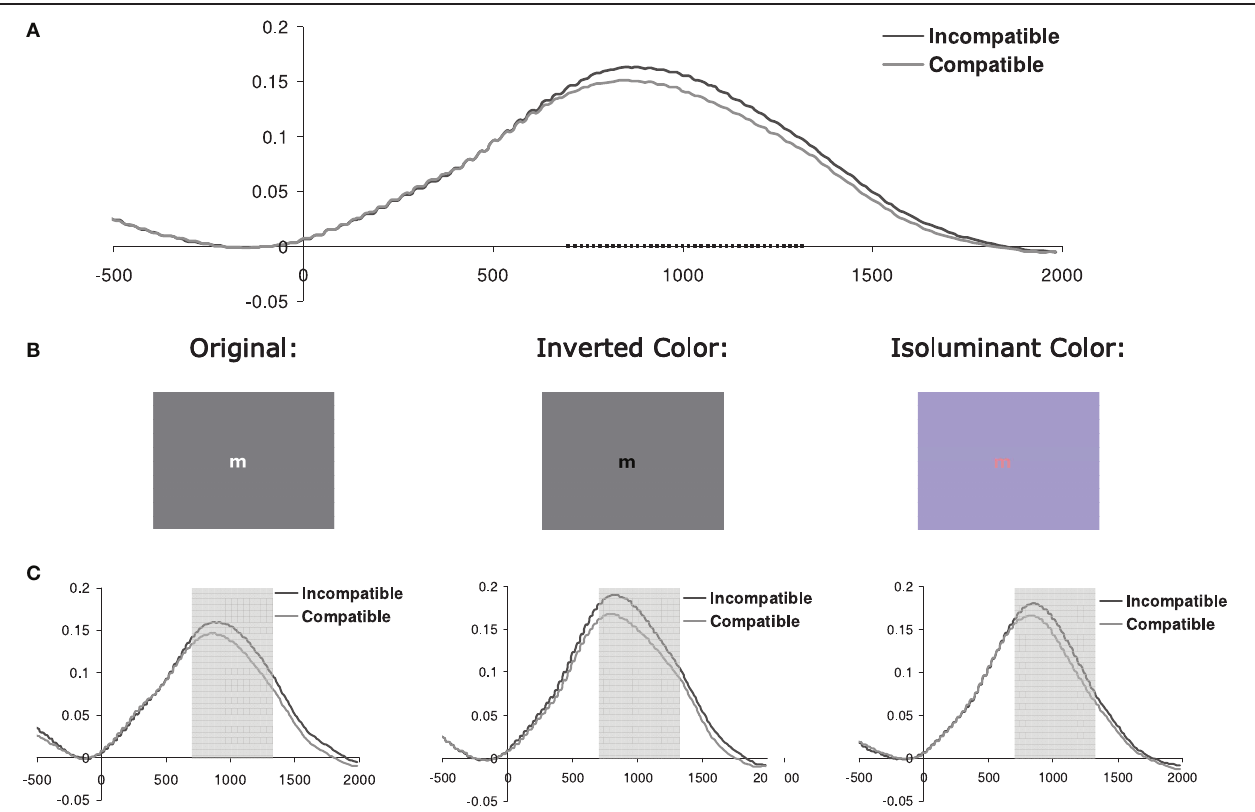
FIGURE 1 | (A) Pupil dilation (in mm; relative to a 200ms prestimulus baseline) for current incompatible vs. compatible trials (pooled across color-scheme conditions) as a function of the onset time (ms) of the stimulus. Squares indicate the samples where paired t -tests showed that the difference between incompatible and compatible trials was